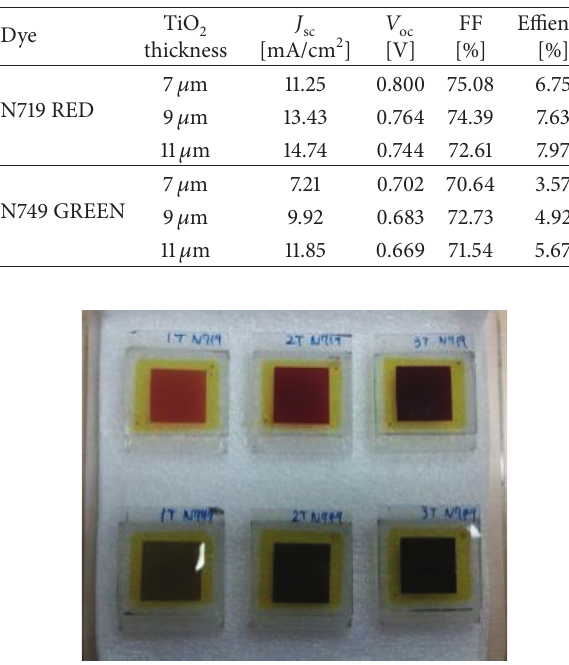
Table 2: Electrical performance of DSCs.